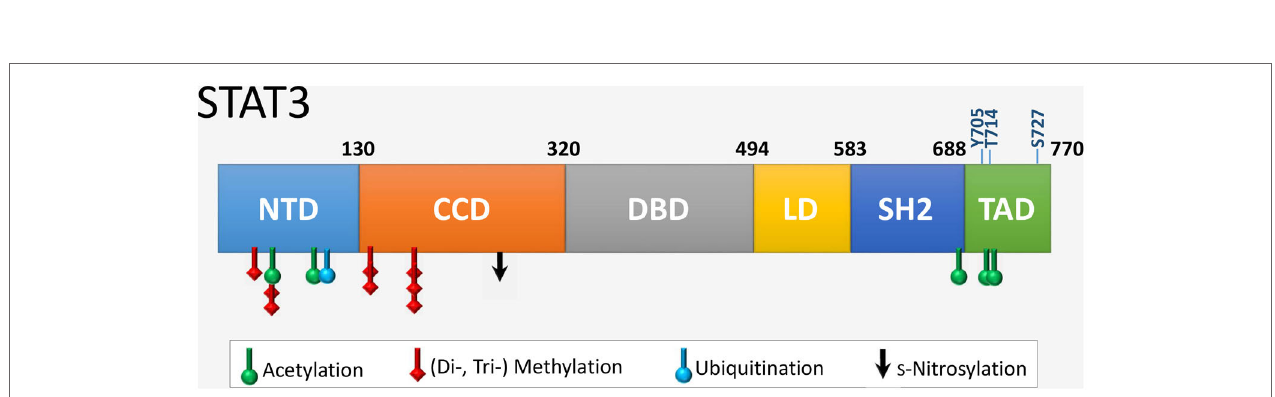
FiGURe 2 | The six functional domains of STAT3 . NTD, NH 2 -terminal domain; CCD, coiled coil domain; DBD, DNA-binding domain; LD, linker domain; SH2 domain; TAD, transcription activation domain. The location of residues that are targets of various posttranslational modifications are indicated. Shown also are the two key regulatory residues by phosphorylation (Y705 and S727) within the TAD, as well as the novel site of phosphorylation T714 linked to transcriptional activity.